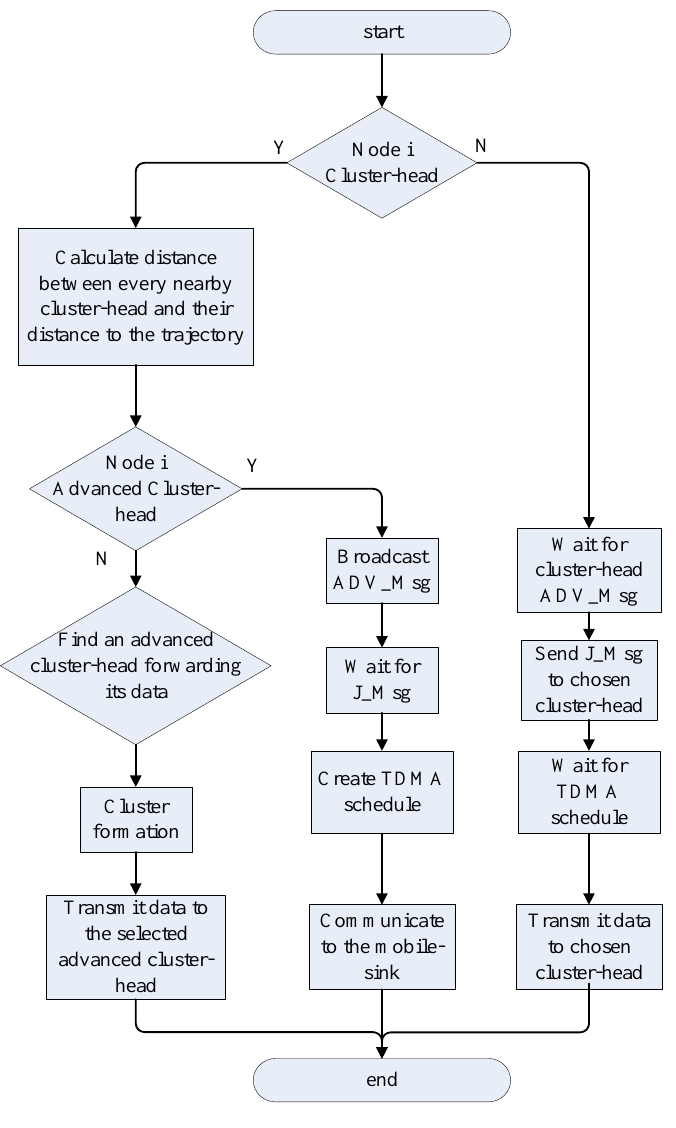
Figure 4. Flowchart of our proposed MSE